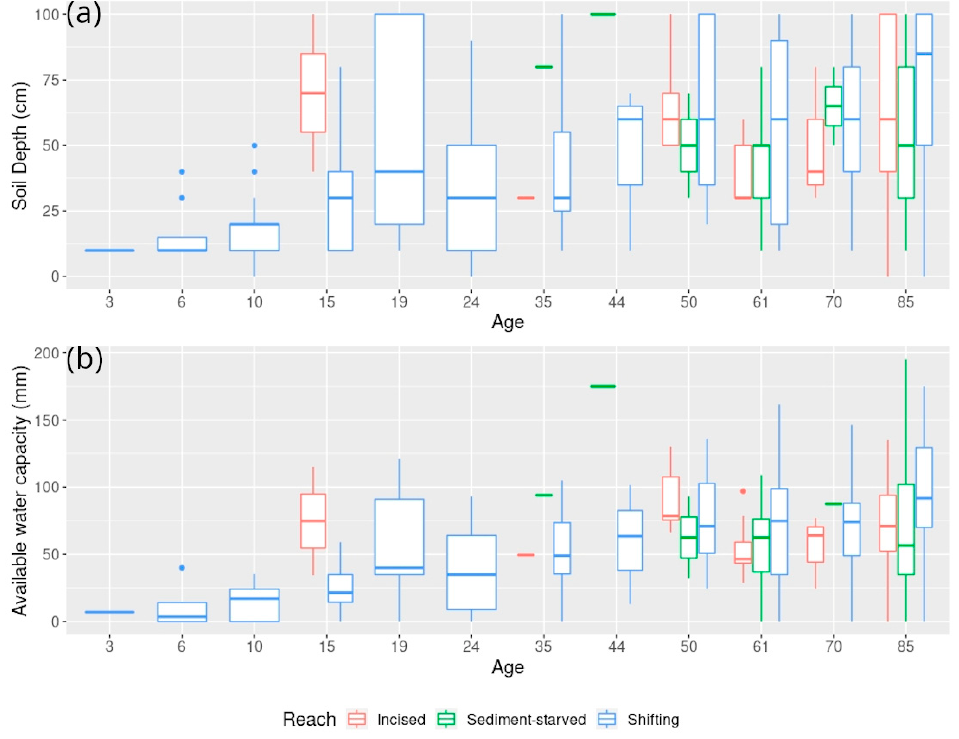
Figure 6. Soil depth measured by hand auger ( a ) and available water capacity ( b ) for ONF forest plots of a given age in all three geomorphic reaches.